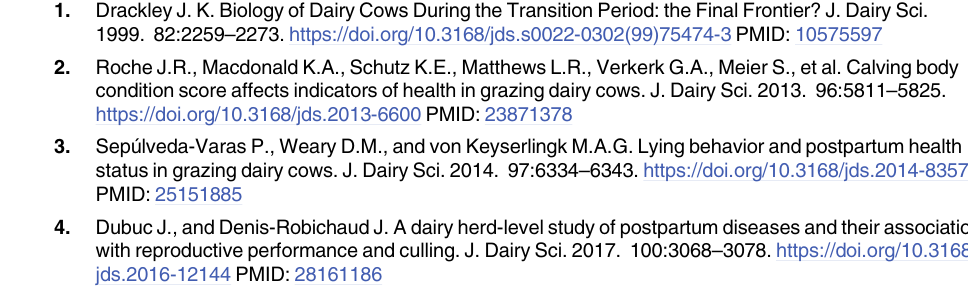
S2 Table. Definition of the activities recorded by RumiWatch 1 noseband sensors and 3D- accelerometers. S3 Table. Criteria for clinical diagnosis of the diseases detected in group-S during the entire study